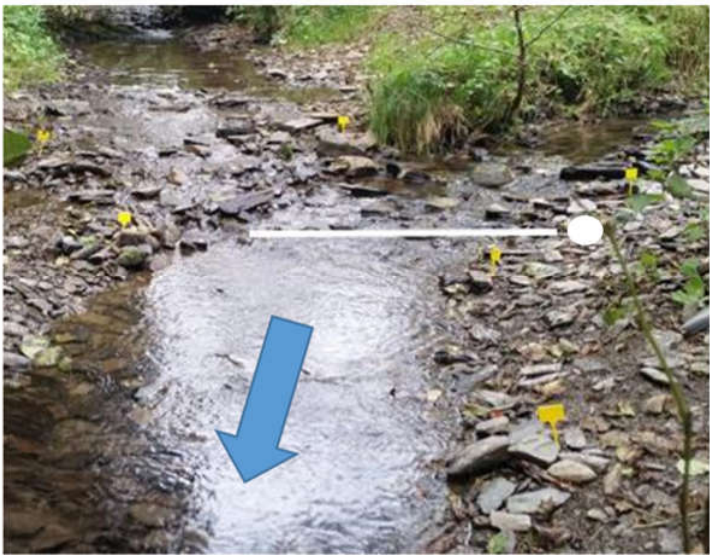
Figure 11. Photograph of measured channel section across the Rennbach-Koulbich confluence. Arrow pointing downstream. (picture M. Antonelli)